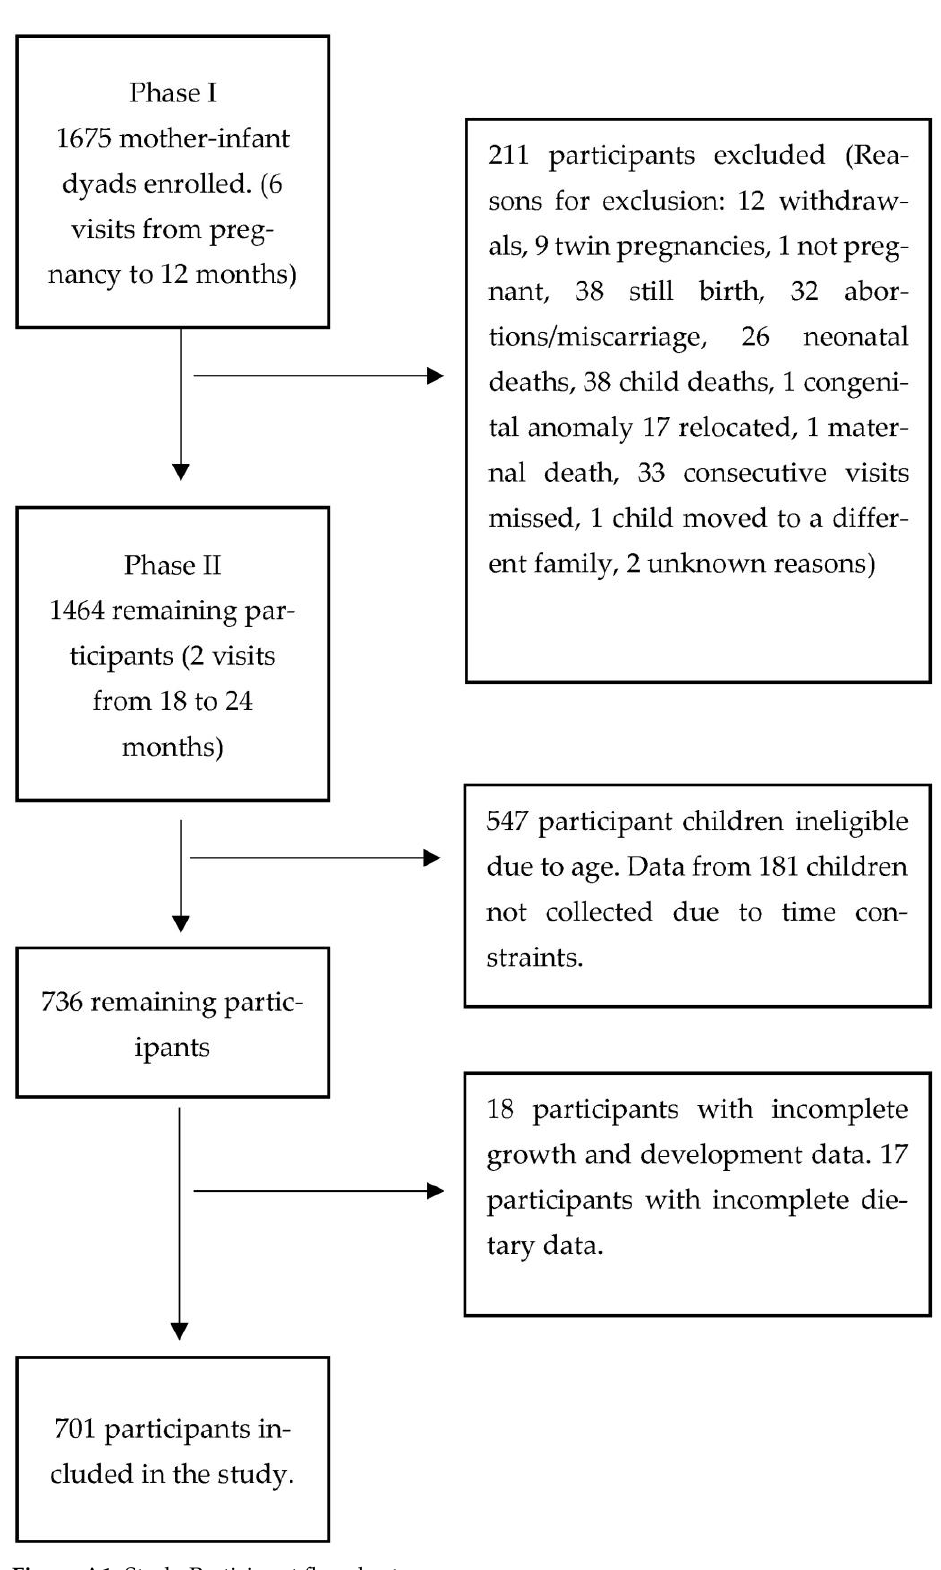
Figure A1. Study Participant flowchart.